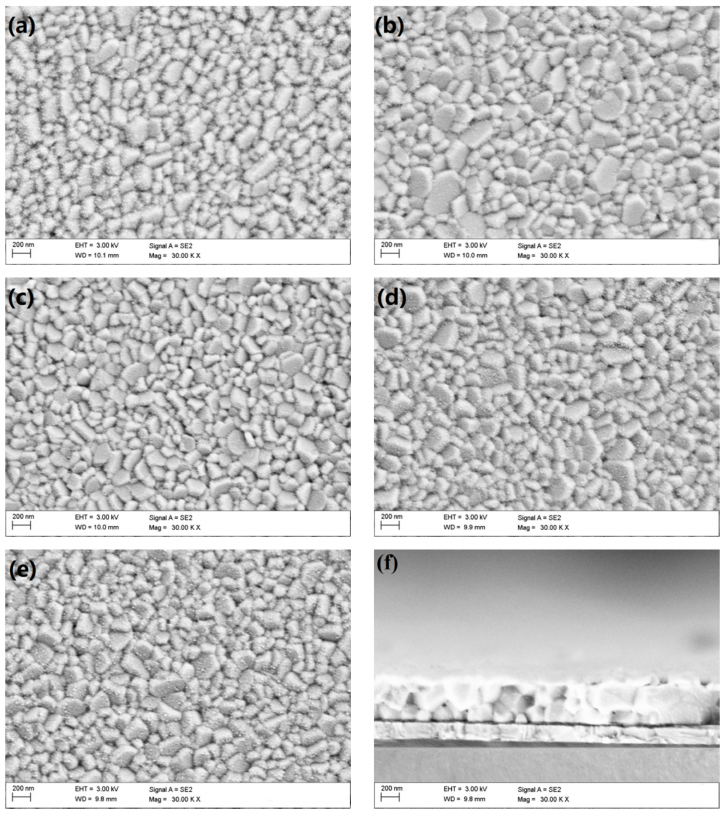
Figure 6. The surface morphology of A, B, C, D, and E regions: ( a ) A region; ( b ) B region; ( c ) C region; ( d ) D region; ( e ) E region; ( f ) Cross-section of MAPbI 3 thin